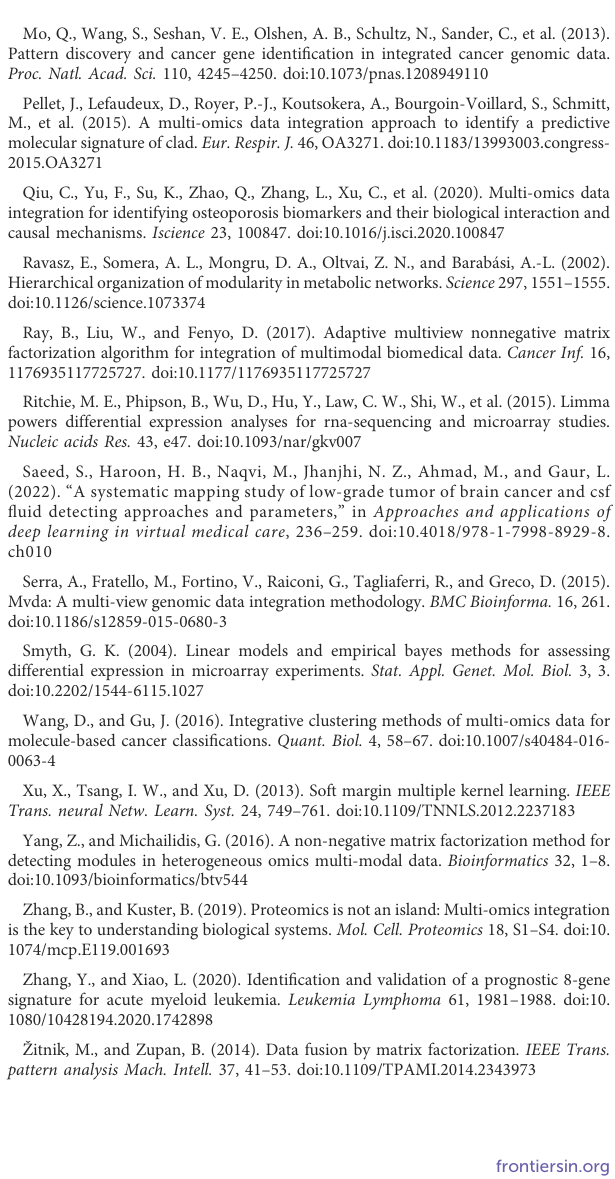
SUPPLEMENTARY FIGURE S1 Detailed fl owchart of the proposed 3PNMF-MKL framework. SUPPLEMENTARY FIGURE S2 Average silhouette width during